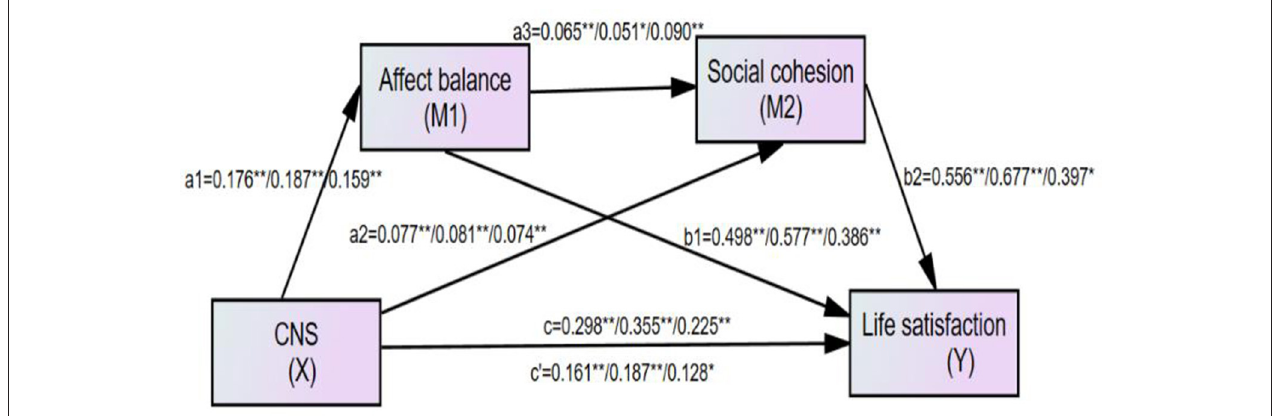
FIGURE 2 | The finalized structural model concerning the relationship between connectedness to nature and life satisfaction: affect balance and social cohesion as mediators. Left numbers, the full sample ( N = 675); Middle number, the adult sample ( N = 386); Right number, the old people sample ( N = 288); c ′ , the direct effect from connectedness to nature to life satisfaction; c , total effect from connectedness to nature to life satisfaction. **Correlation is significant at the 0.01 level. *Correlation is significant at the 0.05 level.